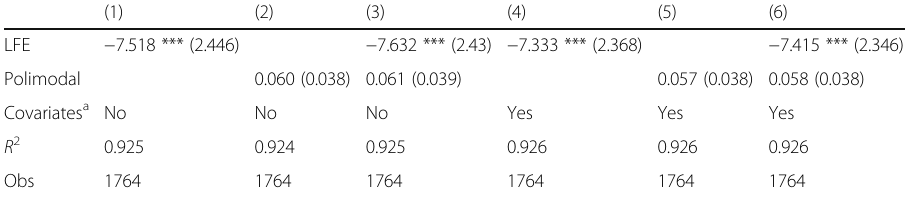
Table 5 The effect of educational reform on fertility (reduced form regressions). OLS estimates of Eq. 3 (within transformation)